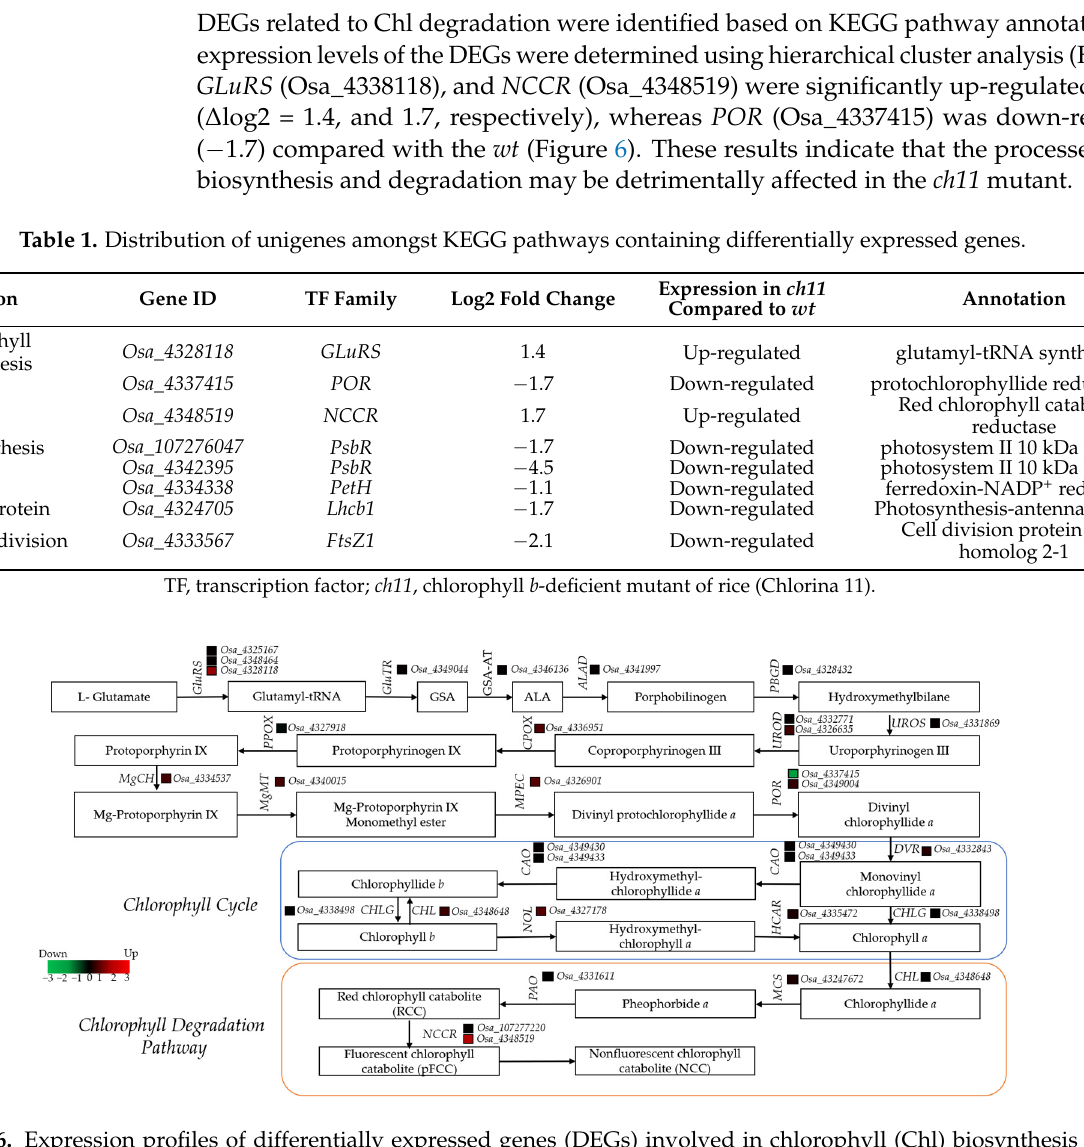
Figure 6. Expression profiles of differentially expressed genes (DEGs) involved in chlorophyll (Chl) biosynthesis and degradation. The expression levels of the Chl b -deficient ( ch11 ) are compared with those of wild-type ( wt ) rice.